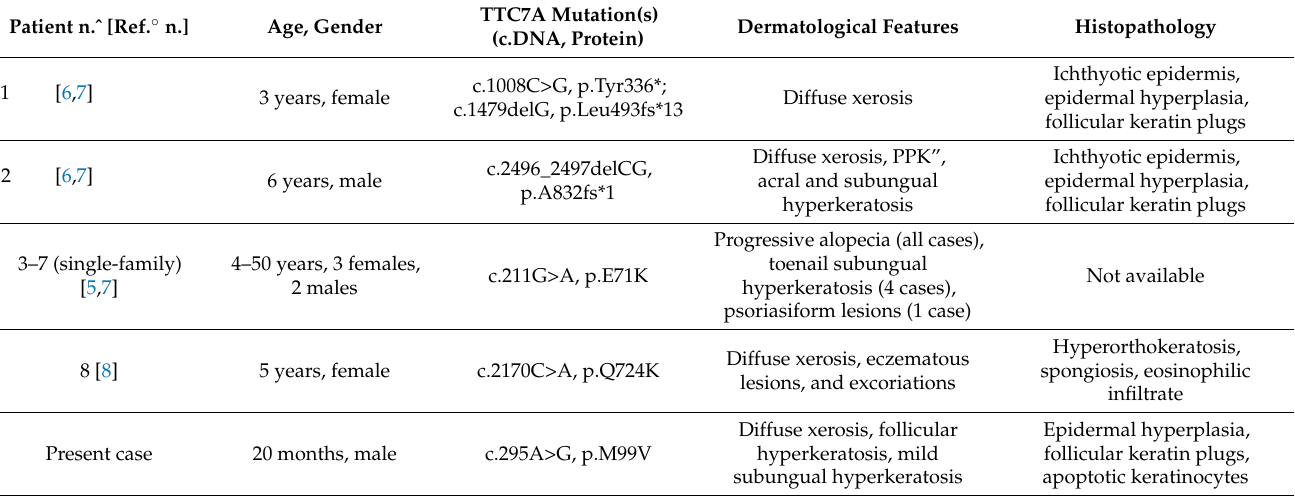
Table 1. Dermatological, histopathological, and molecular features of patients carrying TTC7A mutations. Patient n.ˆ [Ref. ◦